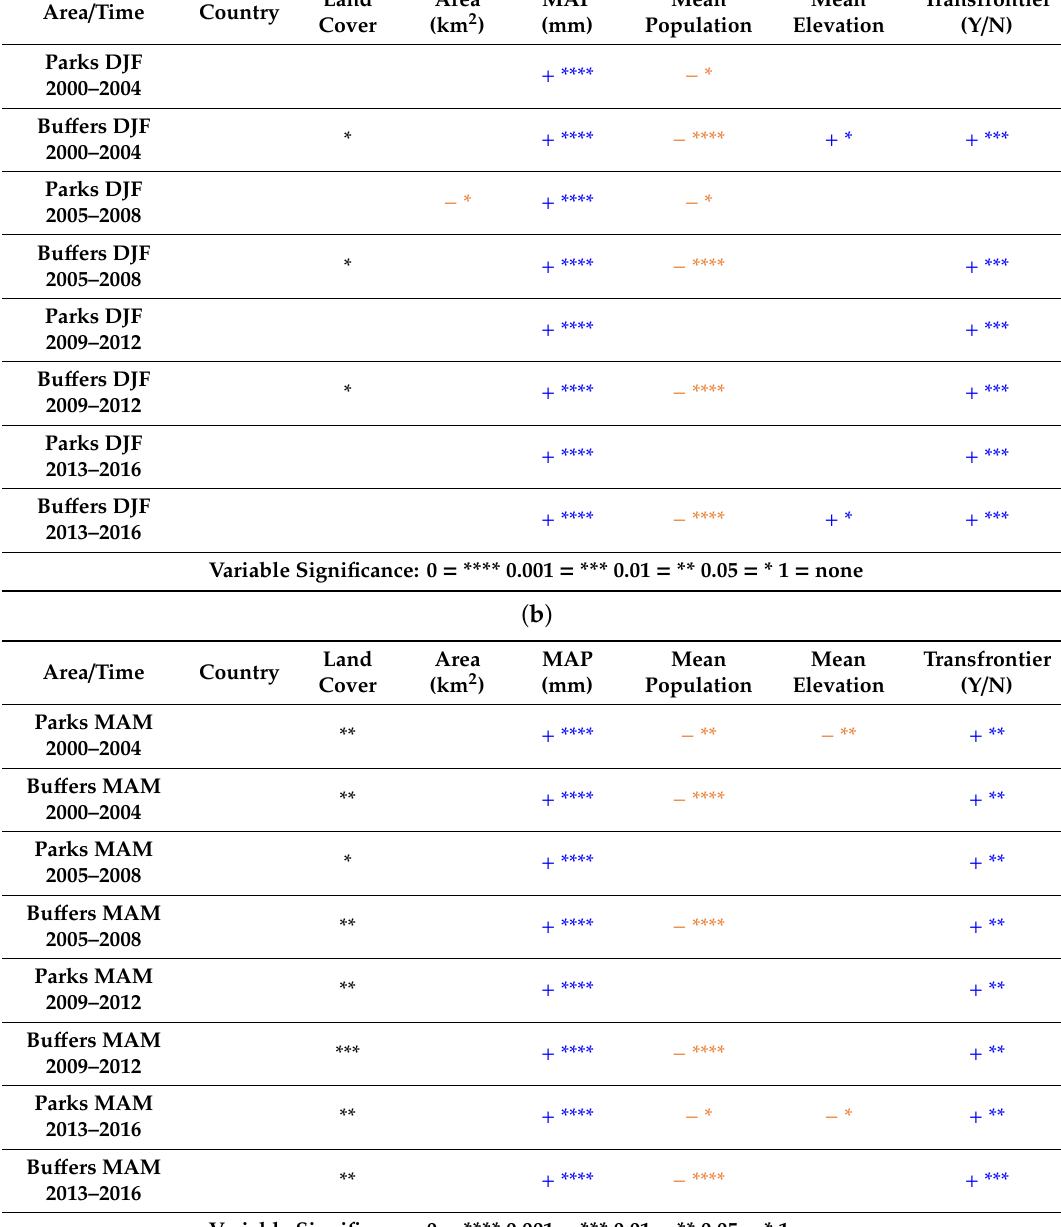
A variable results table of the stepwise backward regression are below in Table 1a,b, and Table 2a,b. This shows each of the variables, when they were significant, how they were significant (positive